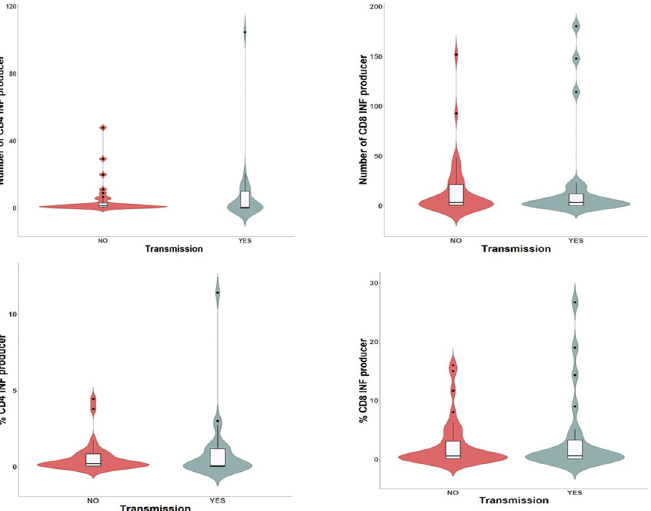
Fig 3. T-cell mediated immune response. Violin plot showing the lymphocyte count and the association of CMV-CD8 + IFN- γ , and CMV-CD4 + IFN- γ with transmission.